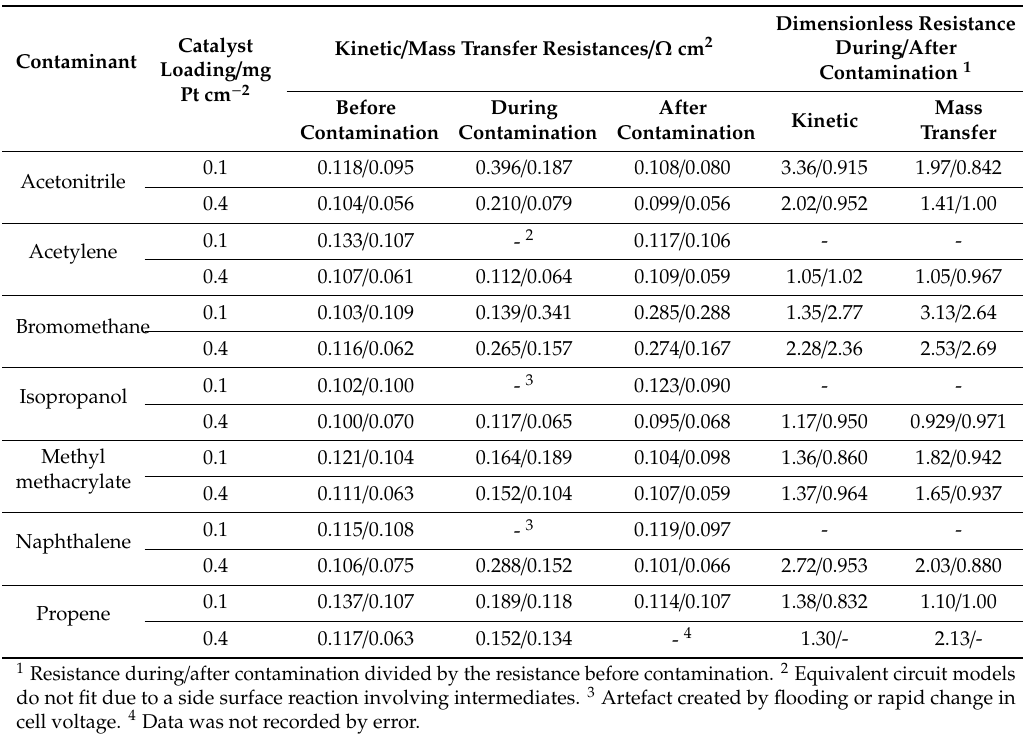
Table 2. Steady-state kinetic and mass transfer resistances at the end of each contamination period, and steady-state dimensionless resistances during and after contamination.